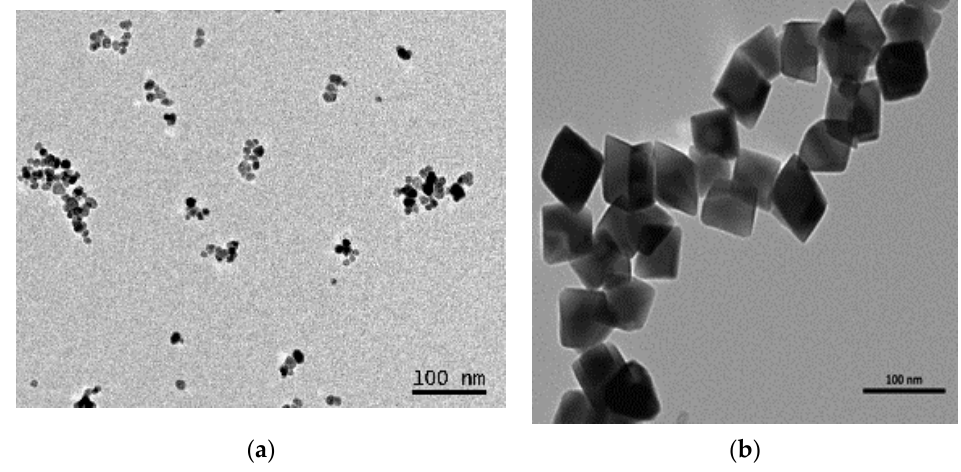
Figure 5. TEM image of ( a ) spherical magnetite NPs coated with citrated and obtained by a coprecipitation method and ( b ) bare cubic magnetite NPs obtained by a precipitation method.